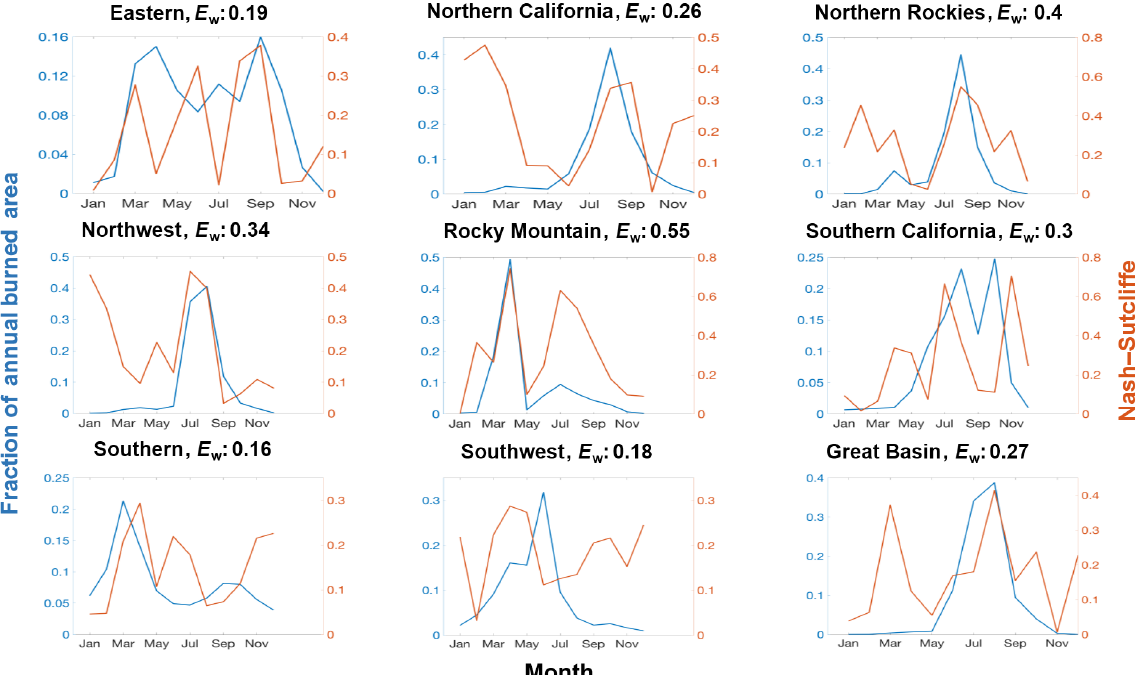
Figure 2. Best-model selection based on the monthly Nash–Sutcliffe coefficient for each GACC. The blue line shows variable peak fire month by mean annual area burned (FAB), and the orange line shows the monthly Nash–Sutcliffe coefficient for each GACC showing variable peak fire month. The weighted Nash–Sutcliffe coefficient is calculated using the different combinations of VPD and SSM. The best model was selected based on the highest E w value, which demonstrates the relative strength of the different models by GACC. Table 1. Overall model performance and separate influence of individual hydrologic variables. We use Nash–Sutcliffe coefficients to describe the combined surface soil moisture (SSM) and vapor pressure deficit (VPD) simulation performance ( E S ), the climatology performance ( E C ), and the individual predictor performance ( E S , VPD E S , ssm ) vs. the observations. GACC AB A E